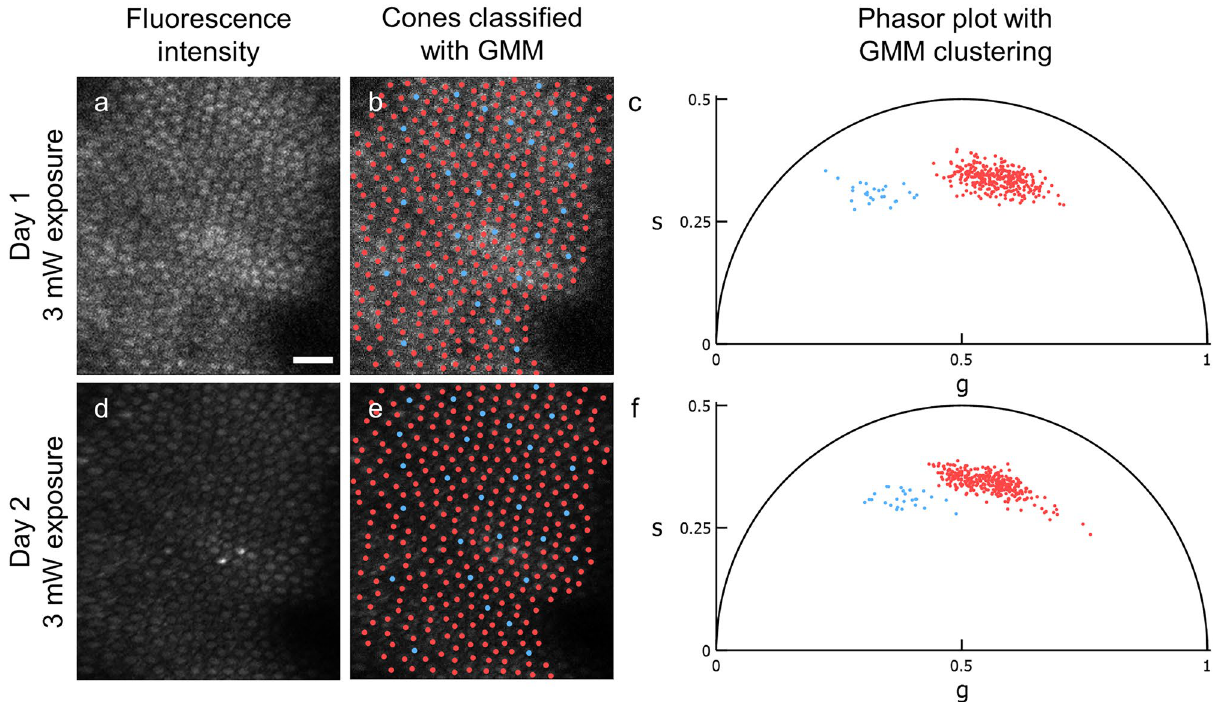
Figure 1. Repeatability of AOFLIO and phasor in partitioning the same cones. Representative fluorescence lifetime data acquired with a low-level exposure (3 mW, 877 J/cm 2 ) taken on two different days at the same location (i.e., initial exposure ( a–c ) and Paradigm 1 ( d–f )). In each fluorescence intensity image ( a,d ), the same 348 cones were marked ( b,e ) in red or blue according to their GMM cluster assignments in the phasor plots ( c,f ). Each phasor coordinate represents one cone. In both exposures, the same 28 cones, representing 8.1% of all cones, were assigned to Cluster 1. Cones obscured by the blood vessel shadow in the right side of the image were not marked. Scale bar represents 20